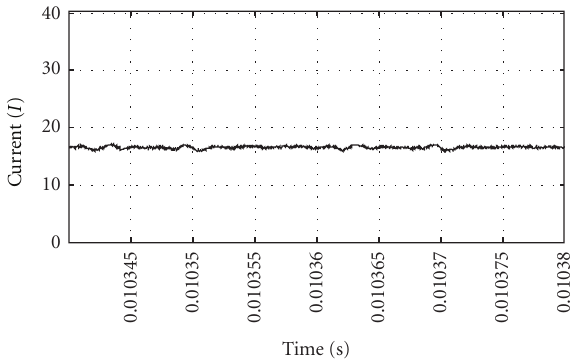
Figure 6: The output current of system with sliding mode.